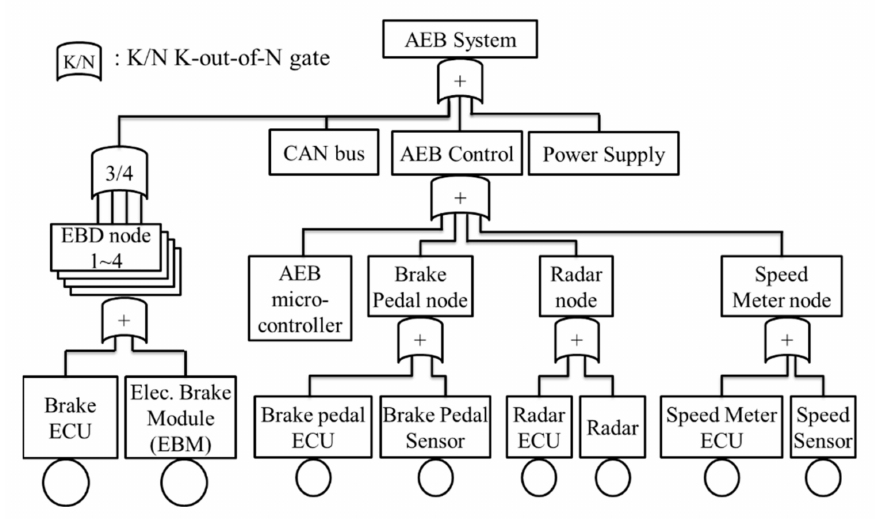
Figure 8. Constructed fault tree of the illustrated AEB